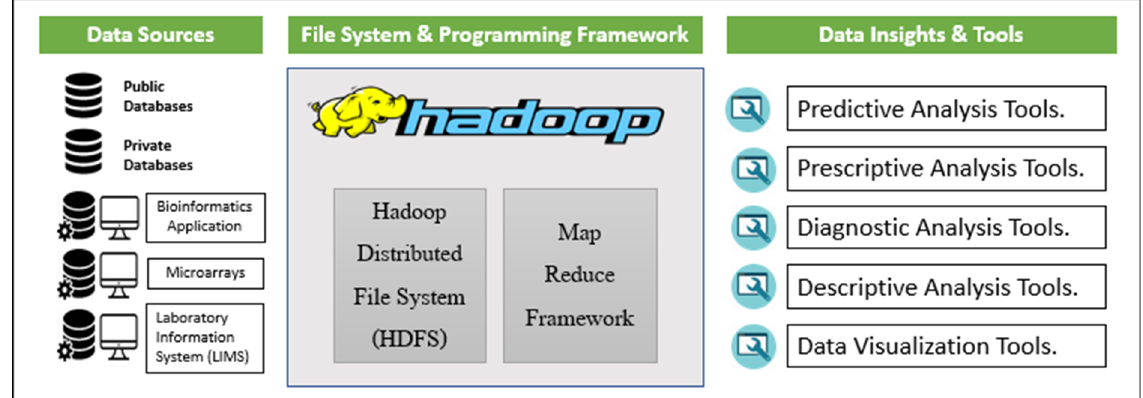
Figure 3. Bioinformatics high-level design.